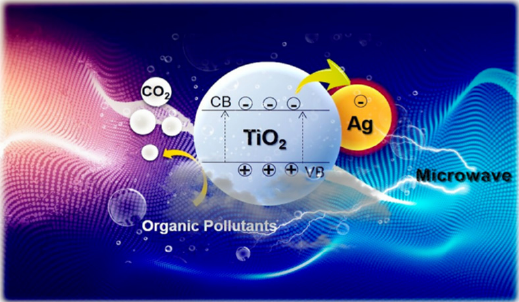
Figure 4. Schematic diagram of microwave-assisted photocatalytic degradation (Reprinted/adapted with permission from Ref. [37]. Copyright 2019, copyright Elsevier).